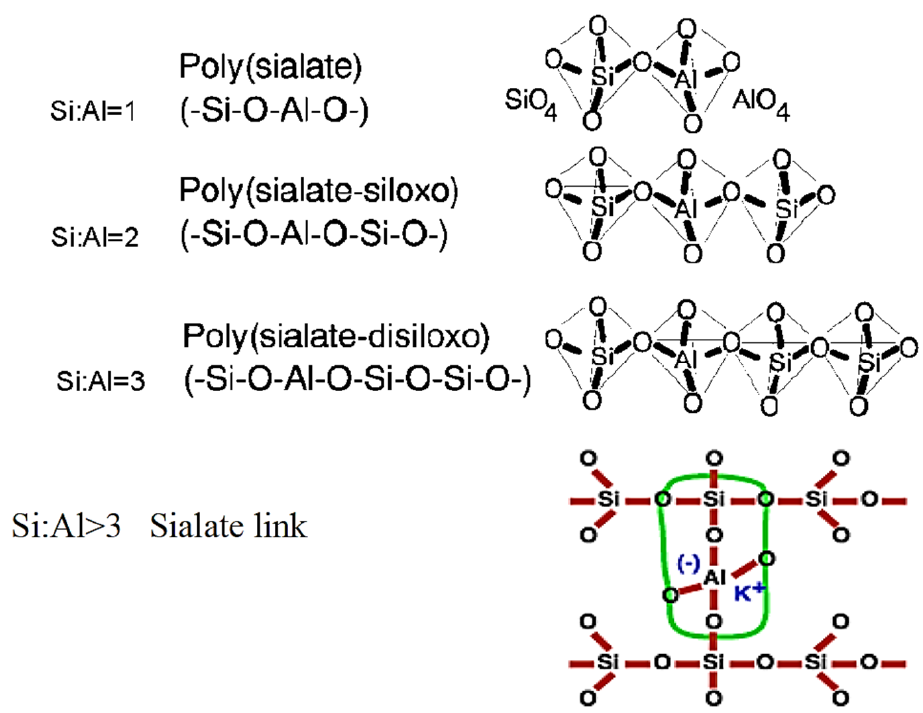
Figure 15. Formation of different aluminum silicate chains in alumino-silicate oligomers depending on the molar S/A ratio, which then forms the GP. Adapted from [85].